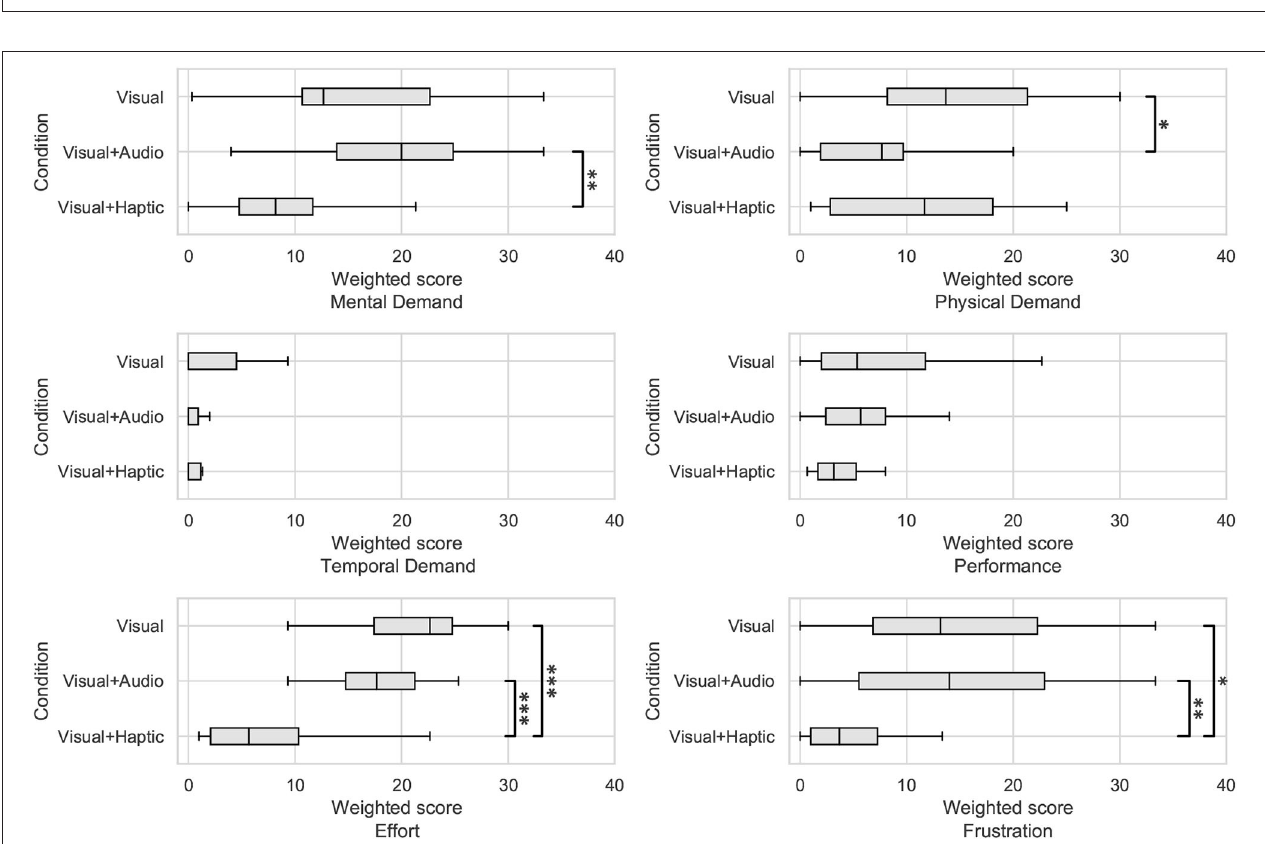
FIGURE 12 | Box plots of each NASA-TLX weighted subjective subscale score in each condition. * p < 0.05, ** p < 0.01, and *** p < 0.001,